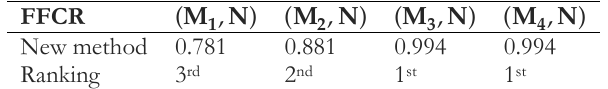
Table 4. Result from problem 1.